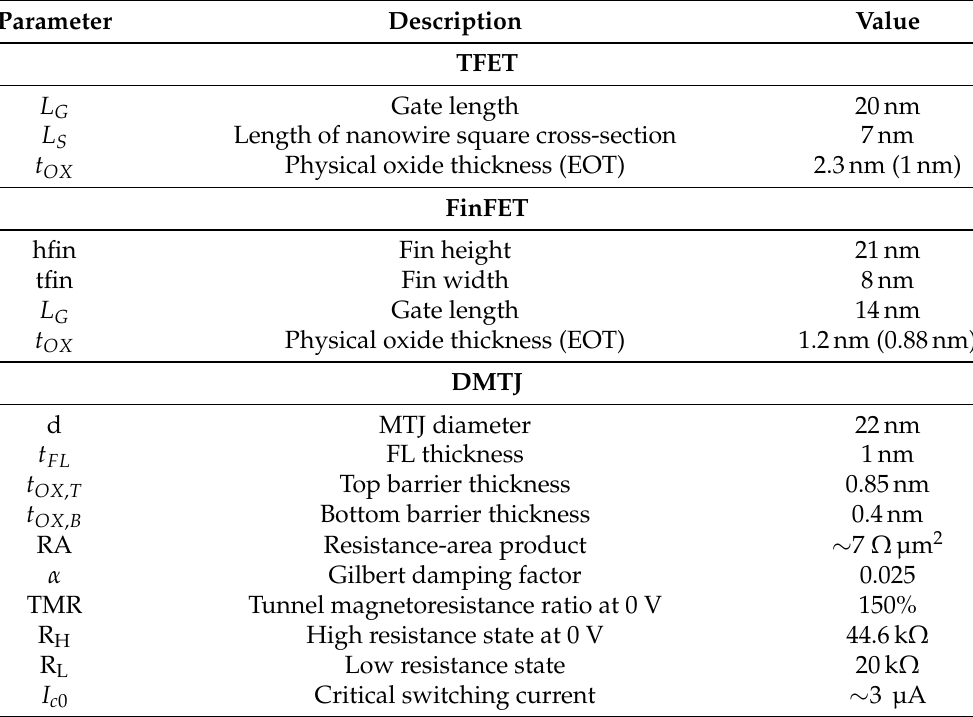
Table 1. Device parameters and